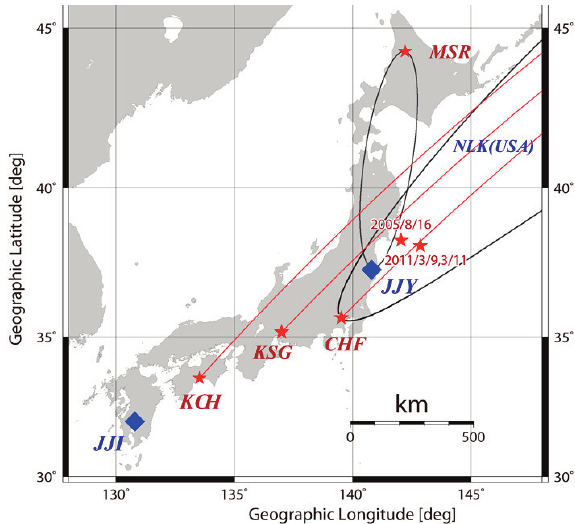
Figure 1. Relative locations of the JJY transmitter and the Moshiri (MSR) station, with the wave sensitive area. Also, the great-circle paths for the NLK (US transmitter) to Japanese receiving stations of Chofu (CHF), Kasugai (KSG) and Kochi (KCH) are shown. The corresponding wave sensitive area is only shown for the NLK–CHF path. The epicenters of the three relevant earthquakes are shown: (i) the August 16, 2005, Miyagi-oki earthquake (2005/8/16); and (ii) the March 9, 2011, foreshock, and the March 11, 2011, main shock earthquakes